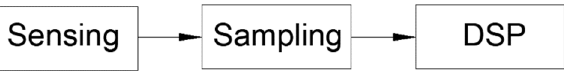
Figure 10. FFT results of the sinusoidal signal at 2.5 kHz in the frequency domain, using 16,384 samples at 1 MHz sampling rate (16.384 ms).